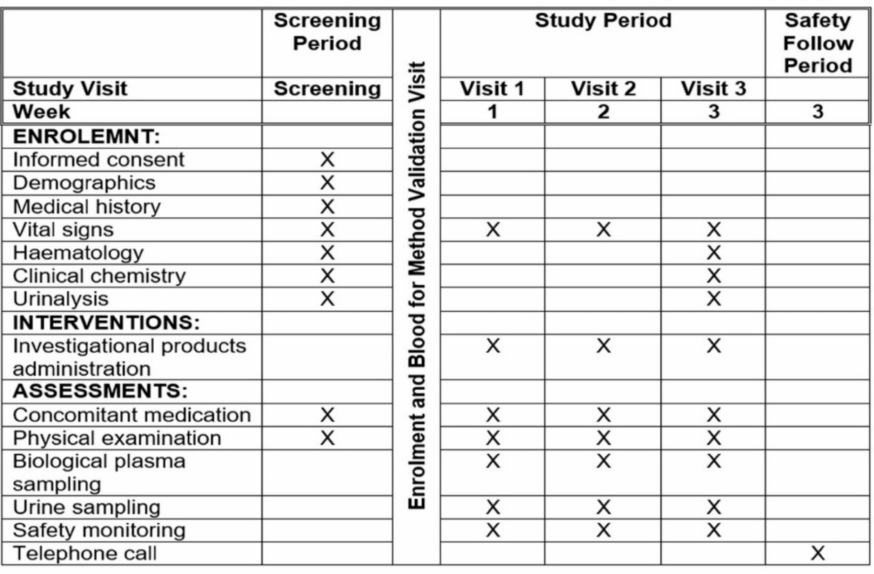
Figure 2. The SPIRIT schedule of enrolment, assessment, and